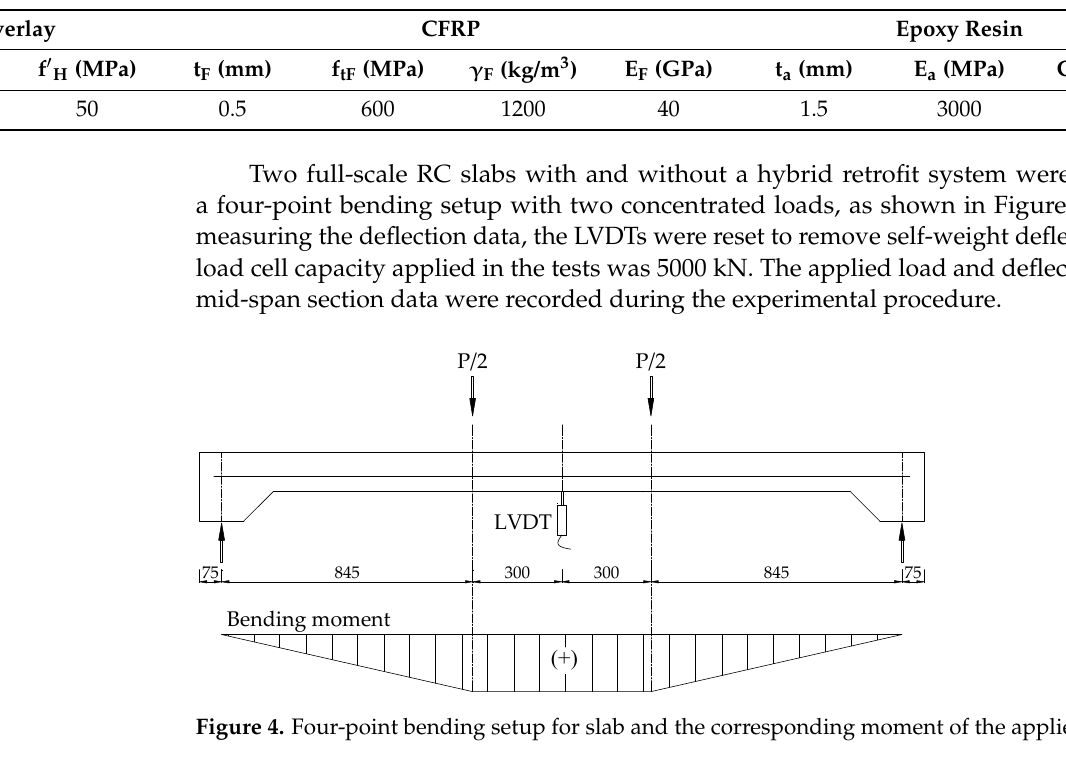
Table 2. Mechanical properties and dimensions for retrofit system.